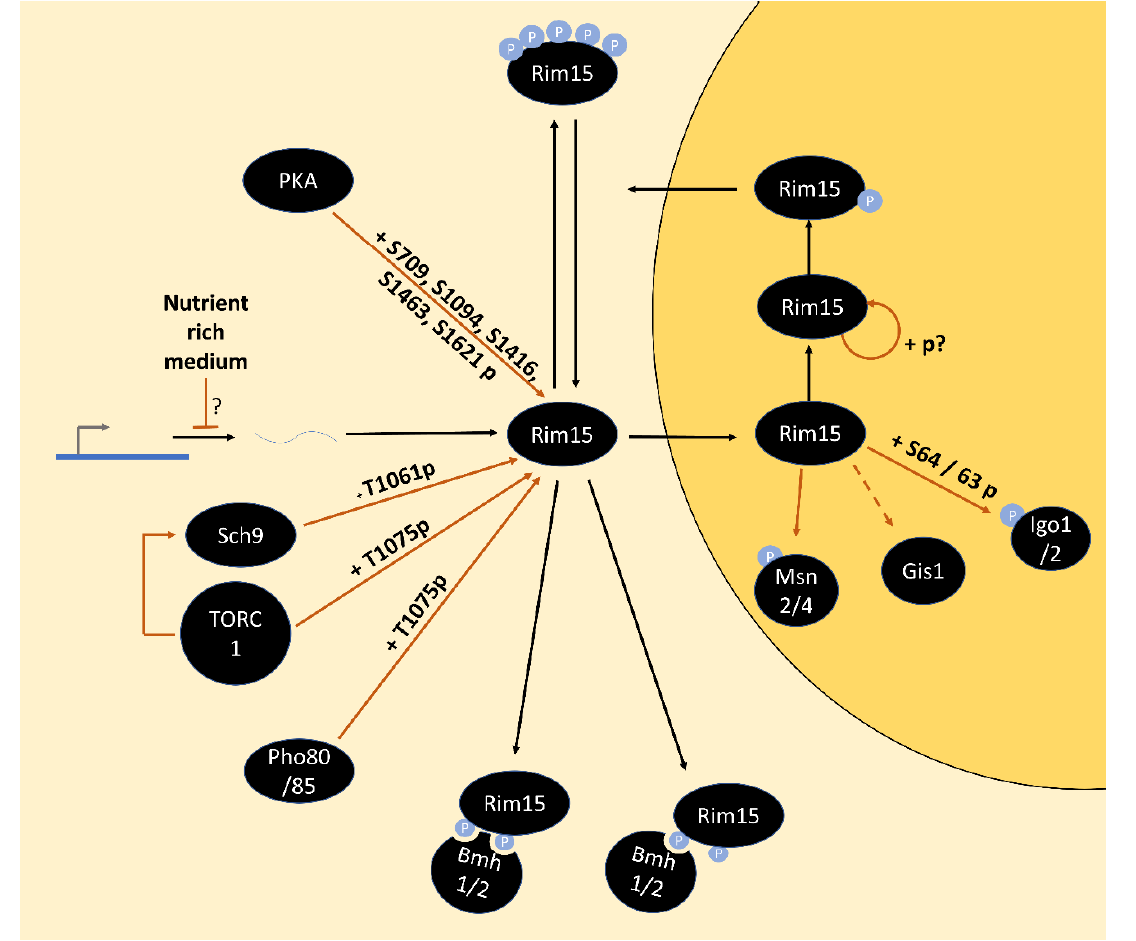
Figure 5. Model for signaling through Rim15. Rim15 is phosphorylated on T1062 by Sch9 and on T1075 by TORC1 and Pho80/85. Phosphorylation of these sites leads to cytoplasmic retention by Bmh1/2. Phosphorylation on five other sites by PKA inactivates Rim15 catalytic activity. This PKA-dependent phosphorylation may be limited to the cytoplasm due to association of PKA catalytic with regulatory subunits in the nucleus. Rim15 autophosphorylation may be required for its nuclear export. A form of Rim15 phosphorylated by both PKA and Sch9/TORC1/Pho80/85 is omitted for clarity. Phosphorylation of substrates by Rim15 is only shown in the nucleus for simplicity, while the true location has not yet been determined.